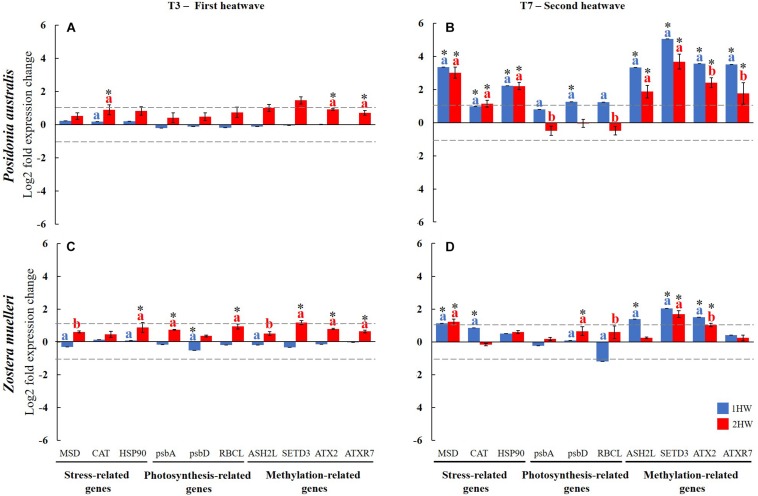
Differential gene expression for GOIs at the end of the first (T3; left panels) and second heatwaves (T7; right panels), respectively. For P. australis
(A,B) and Z. muelleri
(C,D). Data is expressed as log2 Relative Quantification versus the control group. Data are mean, ±SE, n = 3. Pair-wise results are presented on top of the column corresponding to significant difference between control and treatments (asterisk) or between the two treatments (letters), p < 0.05. 1HW: 1 heatwave plants; 2HW: 2 heatwave plants.